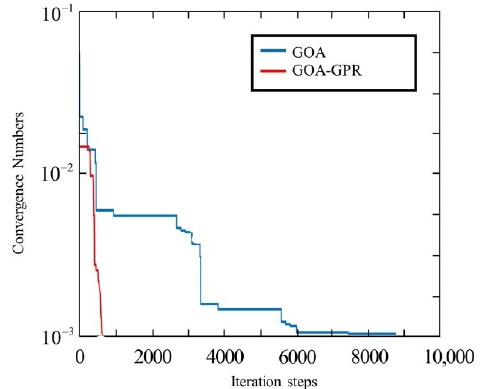
Figure 7. Convergence curve of the test function in Case 2.